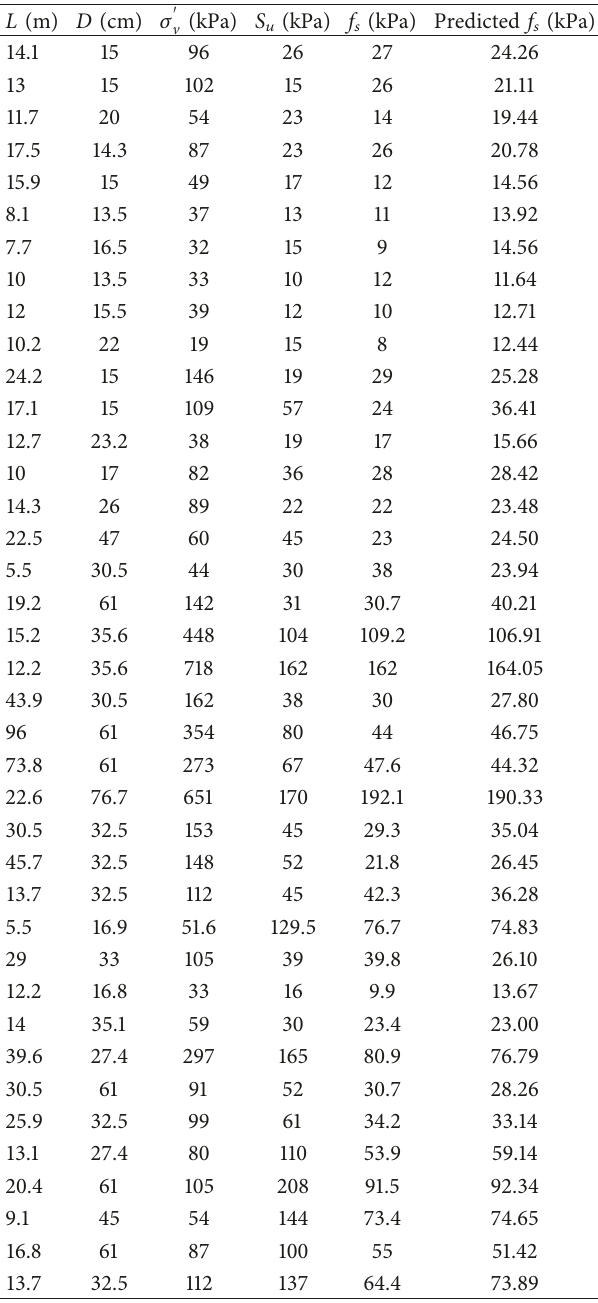
Table 4: Obtained prediction results by ST-LSSVM for training